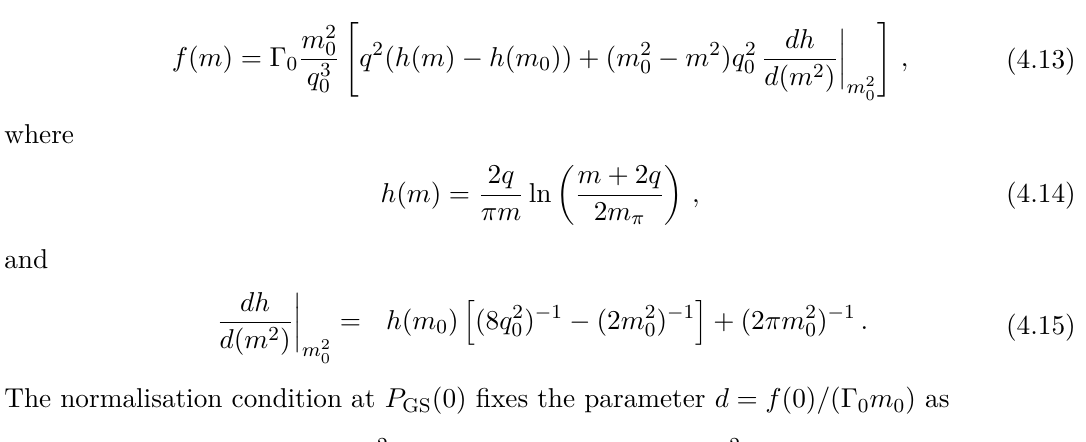
The function f ( m ) is given